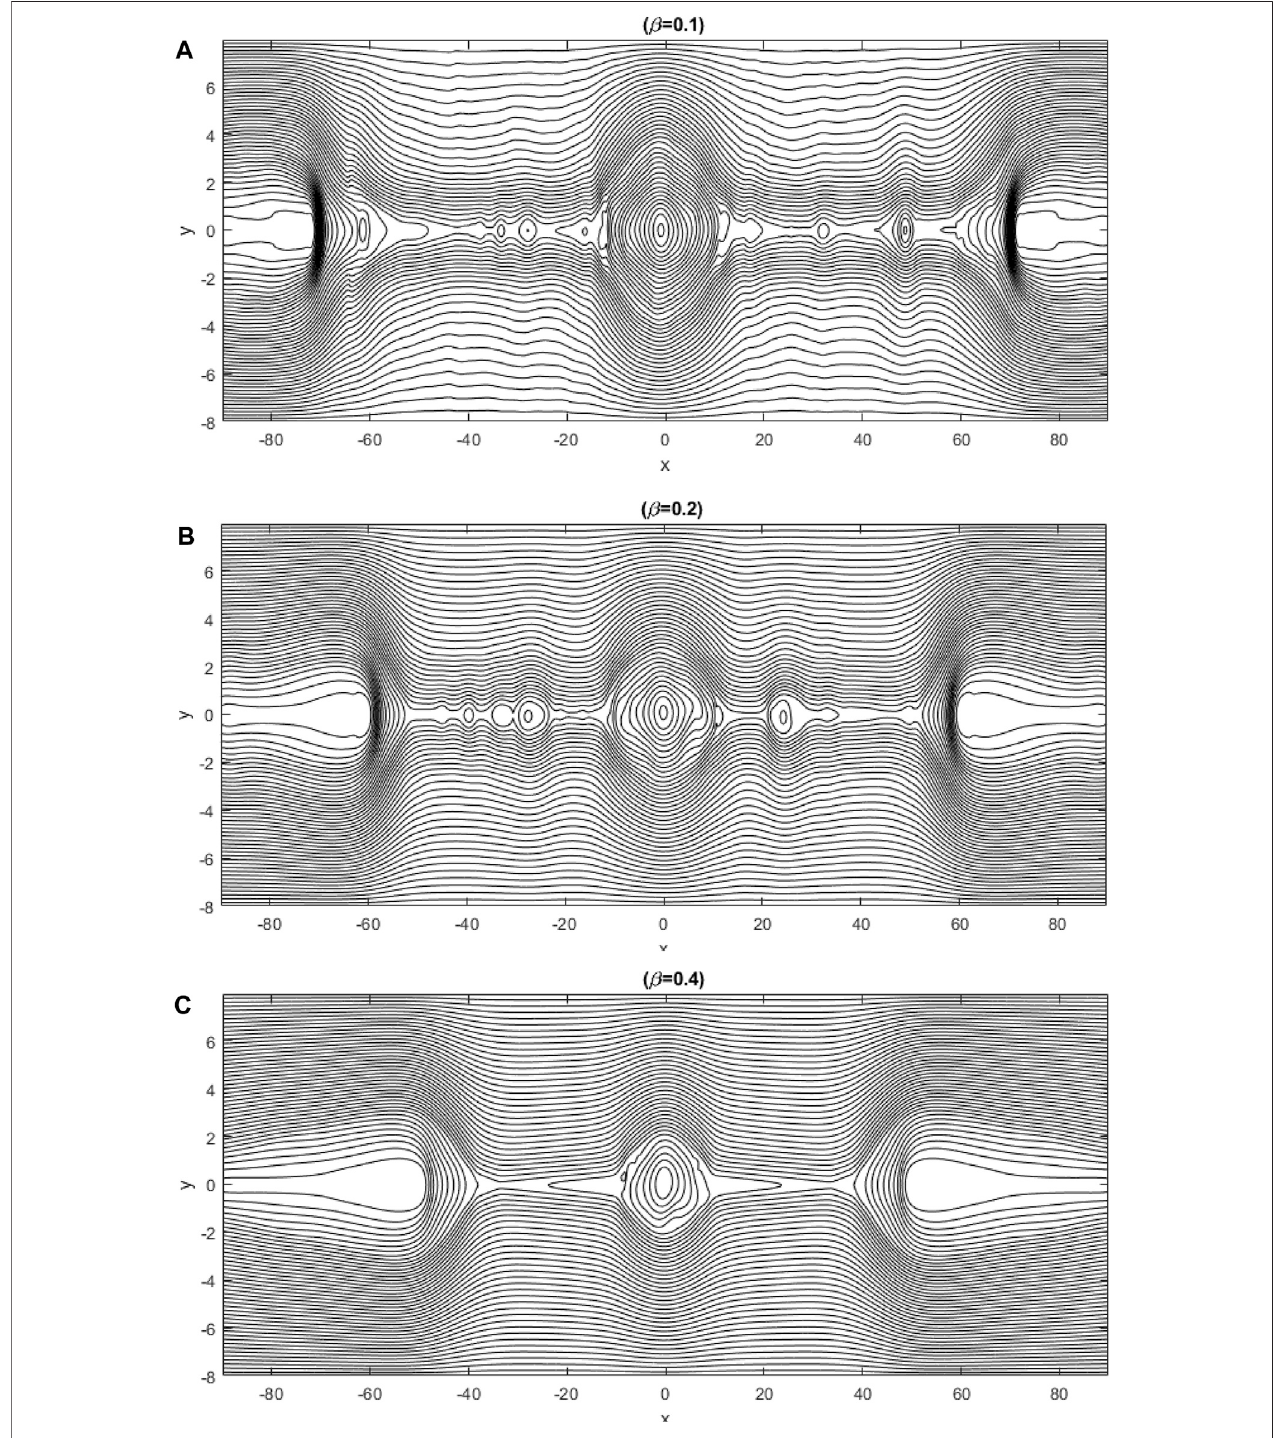
FIGURE 3 | Magnetic fi eld lines for different values of beta at t (cid:1) 95 for (A) : β (cid:1) 0.1, (B) : β (cid:1) 0.2, (C) : β (cid:1) 0.4, (D) : β (cid:1) 0.6, (E) : β (cid:1) 0.8 and (F) β (cid:1) 1.0.